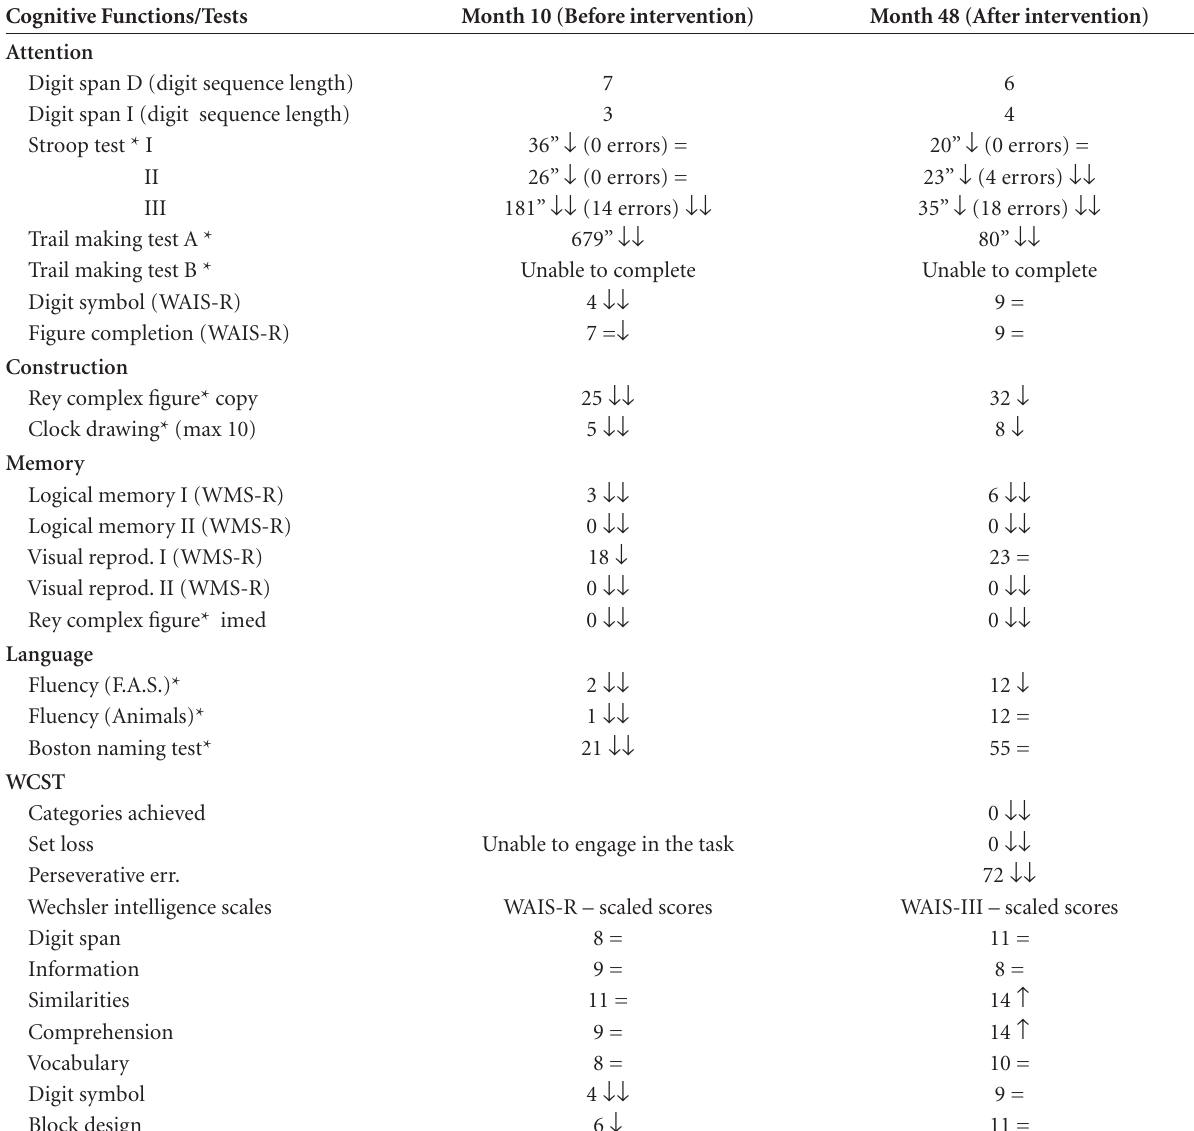
Table 1. Neuropsychological results before and after